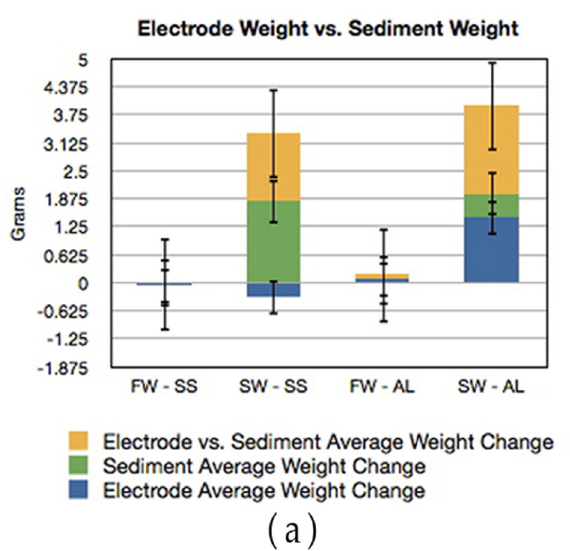
Fig. 4 Electrode and sediment mass gain and loss. The only experiment that showed net average loss was FW-SS, but the amount lost was negligible. The largest sediment collected was 2.68 g, which was collected from SW-SS experiment set #1. A larger sedimentation average weight gain was established with Al6061 electrodes. Trace amounts of Ag were detected on all electrodes surfaces post experiment with Al electrodes. Error bars denote ± 1 standard